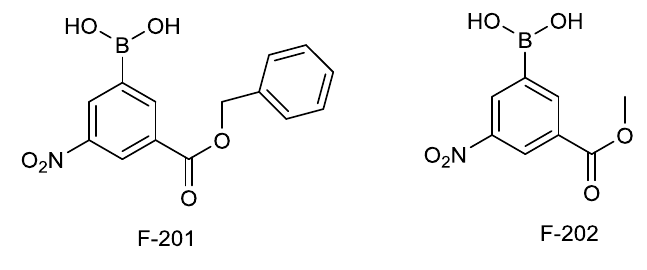
Figure 14. Chemical structure of arylboronic